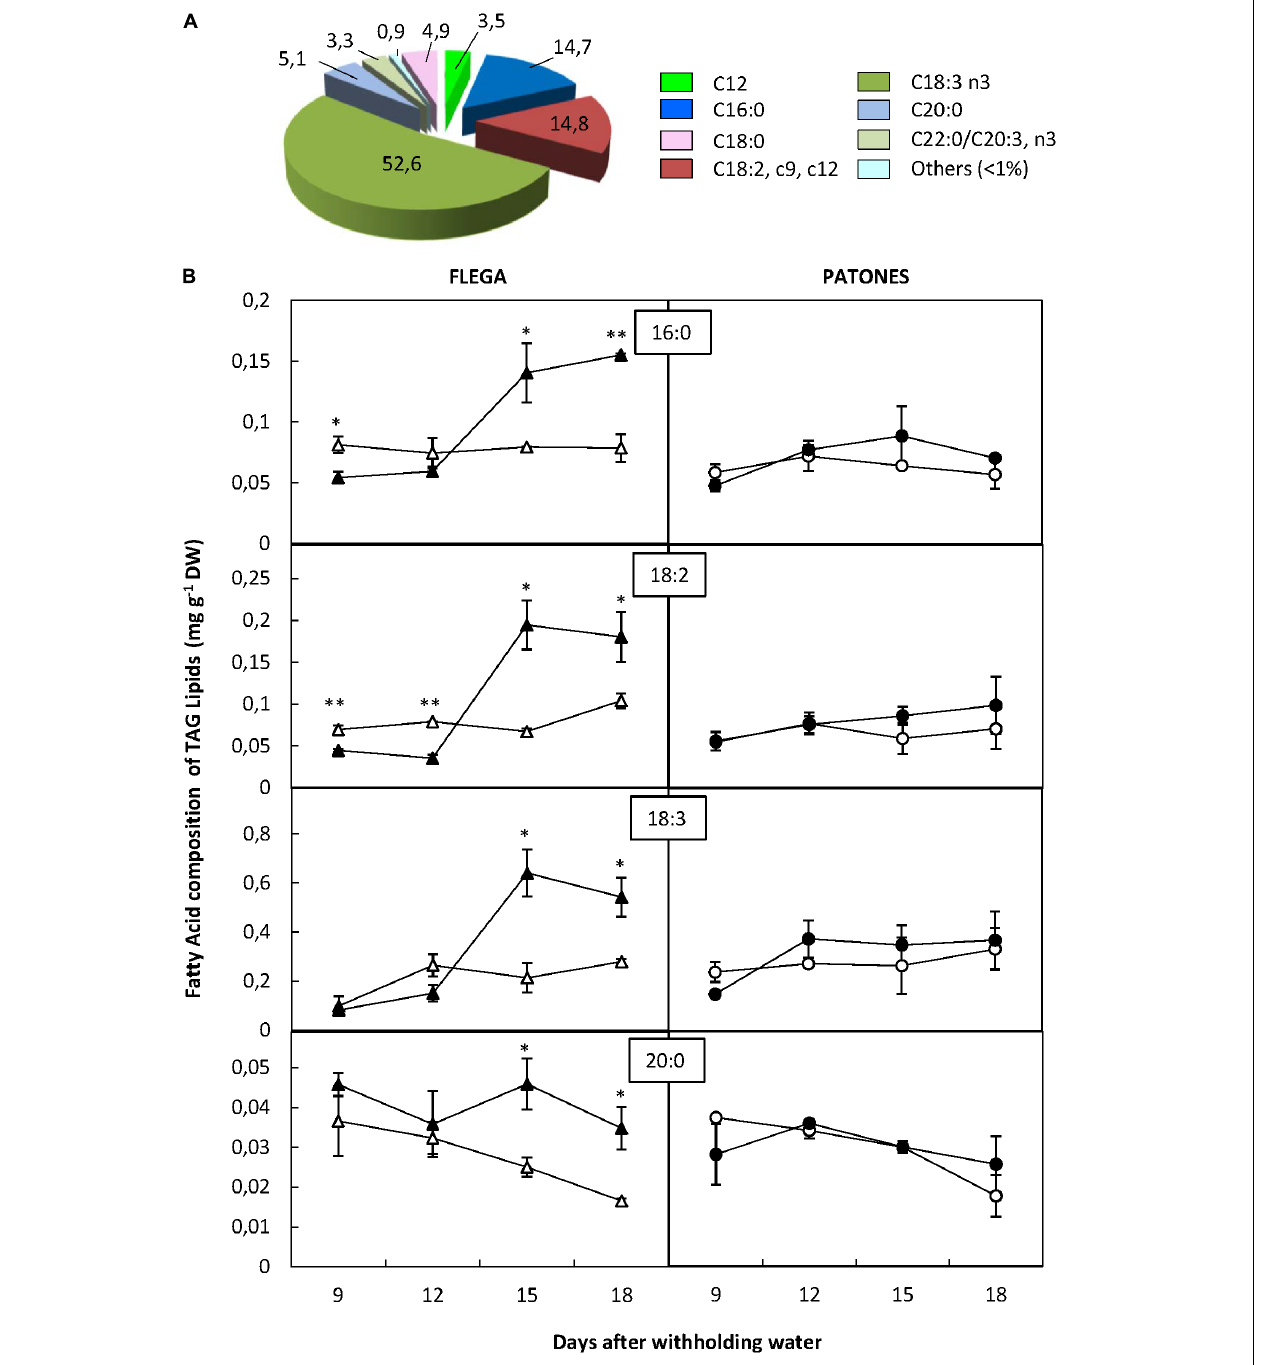
FIGURE 5 | Fatty acid content of triacylgliceride fraction. (A) Fatty acid distribution within triacylgliceride fraction. The proportion of fatty acids detected in the fraction was calculated from a profiling of 92 fatty acids. (B) Fatty acid content. Fatty acids accounting for at least 5% of the fraction were quantified in drought susceptible Flega (triangles) and resistant Patones (circles) well-watered plants (open symbols) and during a time course of water stress (solid symbols) (9, 12, 15, and 18 days). Data are mean of five replicates ± standard error. ∗ and ∗∗ indicate significant differences at P < 0.05 and 0.01, respectively.